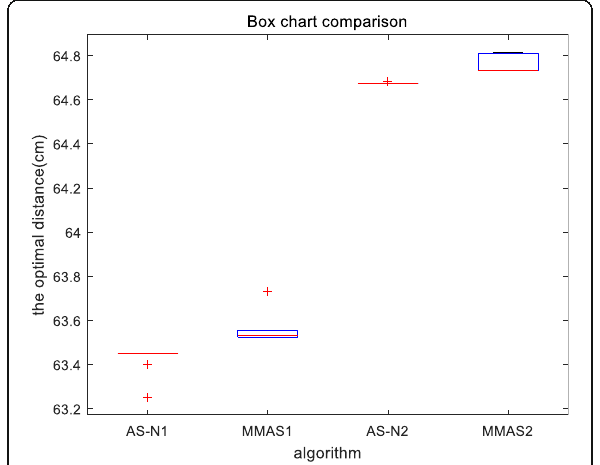
Fig. 10 Complex environment 1 convergence chart